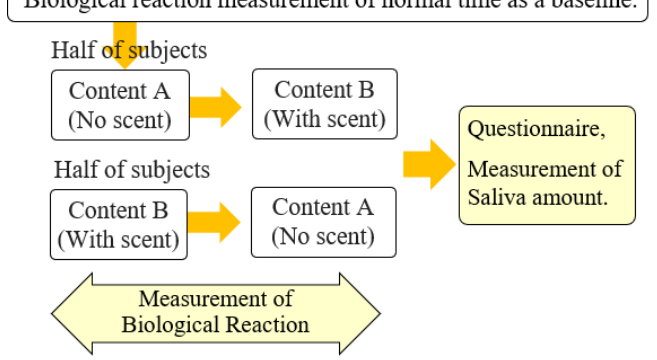
Figure 4. Experimental procedure.